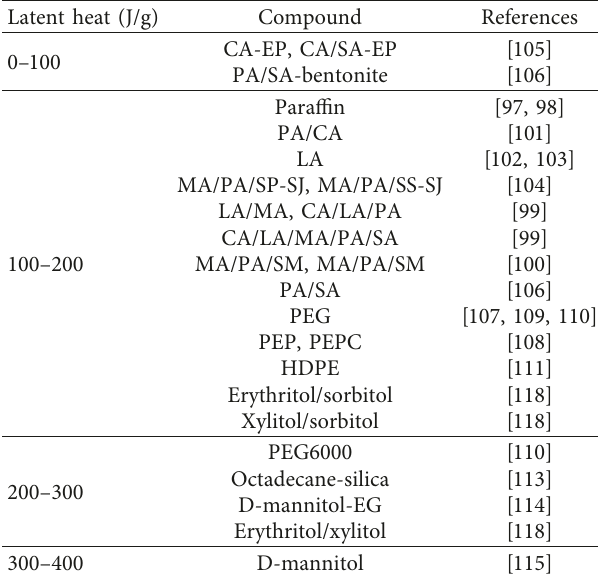
Table 8: The latent heat of organic eutectic